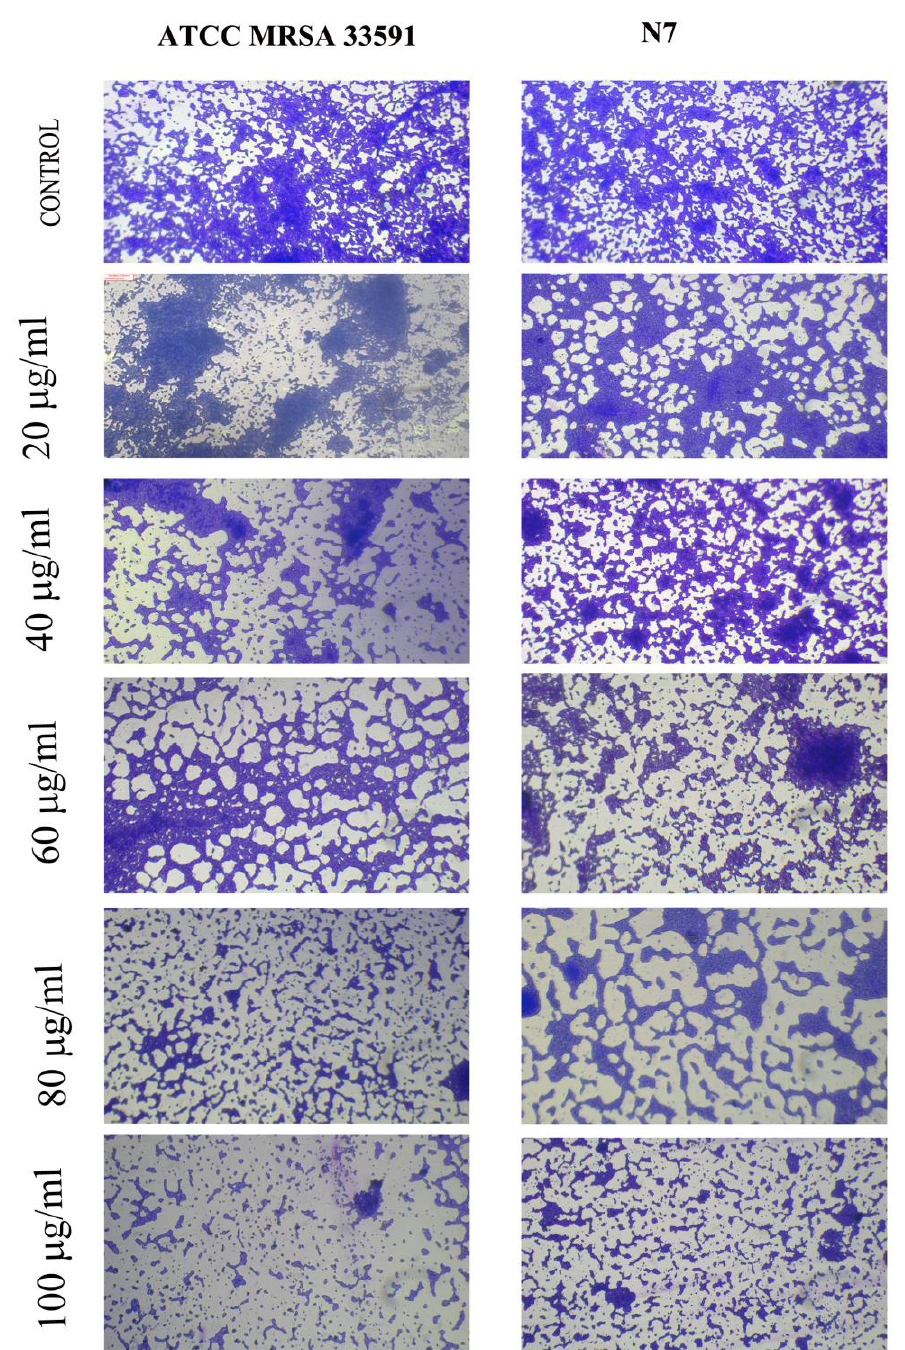
Figure 8. Light microscopic images anti-biofilm formed bacteria after treatment of MG@Folat ZIF-L nanoframeworks in different concentrations.